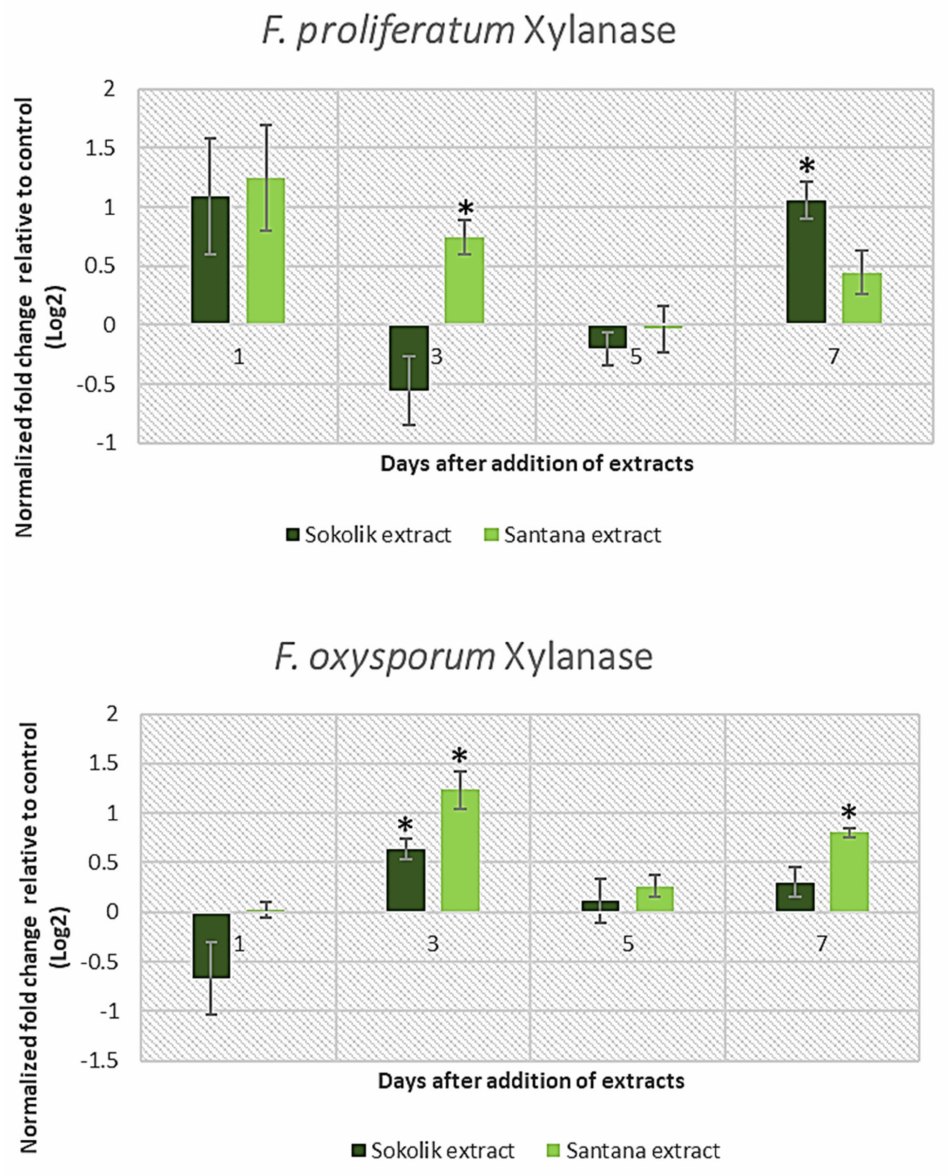
Figure 2. Xylanase gene expression of F. proliferatum (PEA1) and F. oxysporum (1757 OX) from day 1 to day 7 after the addition of the Sokolik and Santana extracts. Error bars represent the standard error. * Statistically significant ( p <